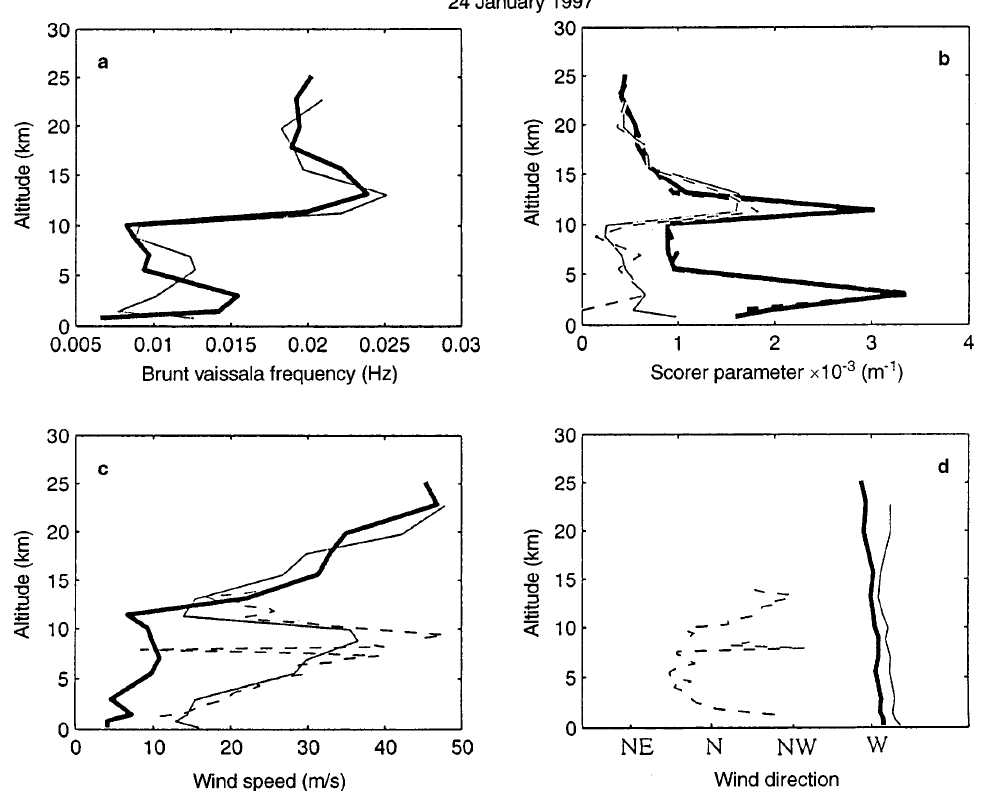
Fig. 11. Profiles for 24 January for 0 UT ( thin line ) and 12 UT ( thick line ) of a Brunt Vaissala frequency from radiosonde from Bodo. b Scorer parameter from radiosonde from Bodo ( solid line : simplified, dashed : full expression, see text). c Wind Intensity from radiosonde